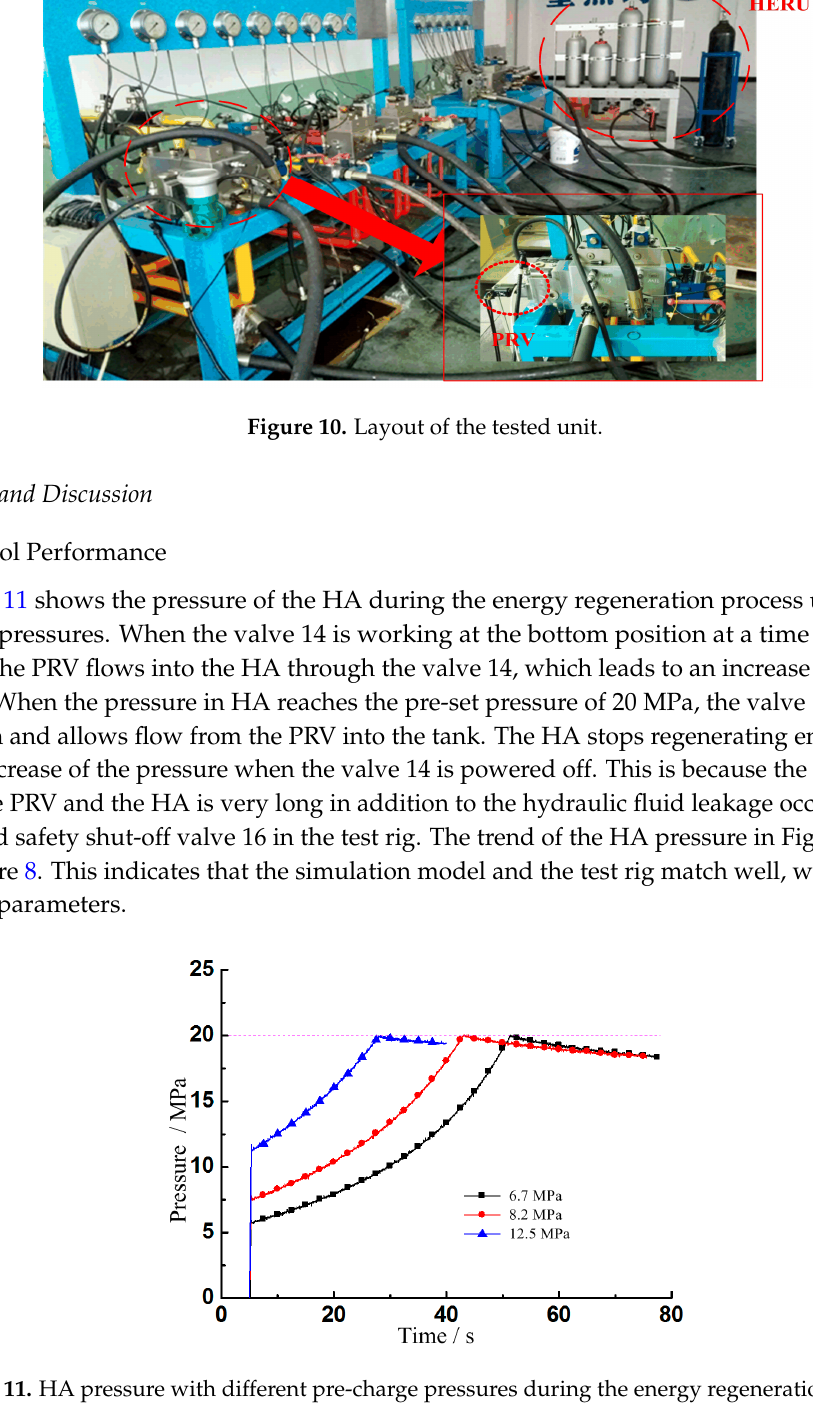
Figure 11. HA pressure with different pre-charge pressures during the energy regeneration process.